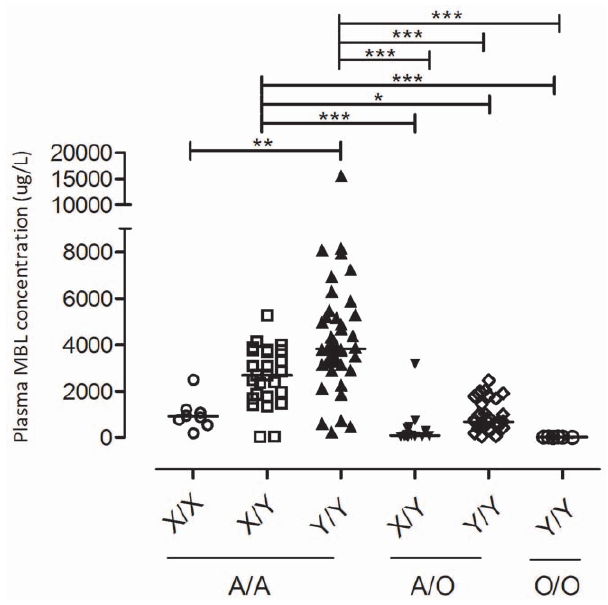
Figure 1. MBL2 XA/XA, XA/YA, YA/YA, XA/YO, YA/YO, YO/YO genotypes with the corresponding plasma MBL concentrations (** p , 0.01, *** p , 0.001).